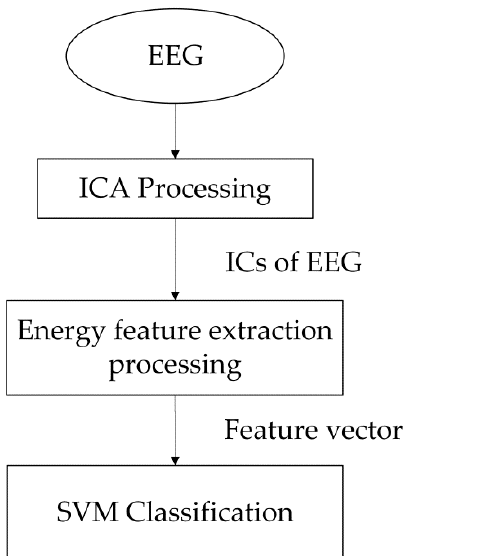
Figure 5. Implementation of Method 1( a ) and Method 2( b ).